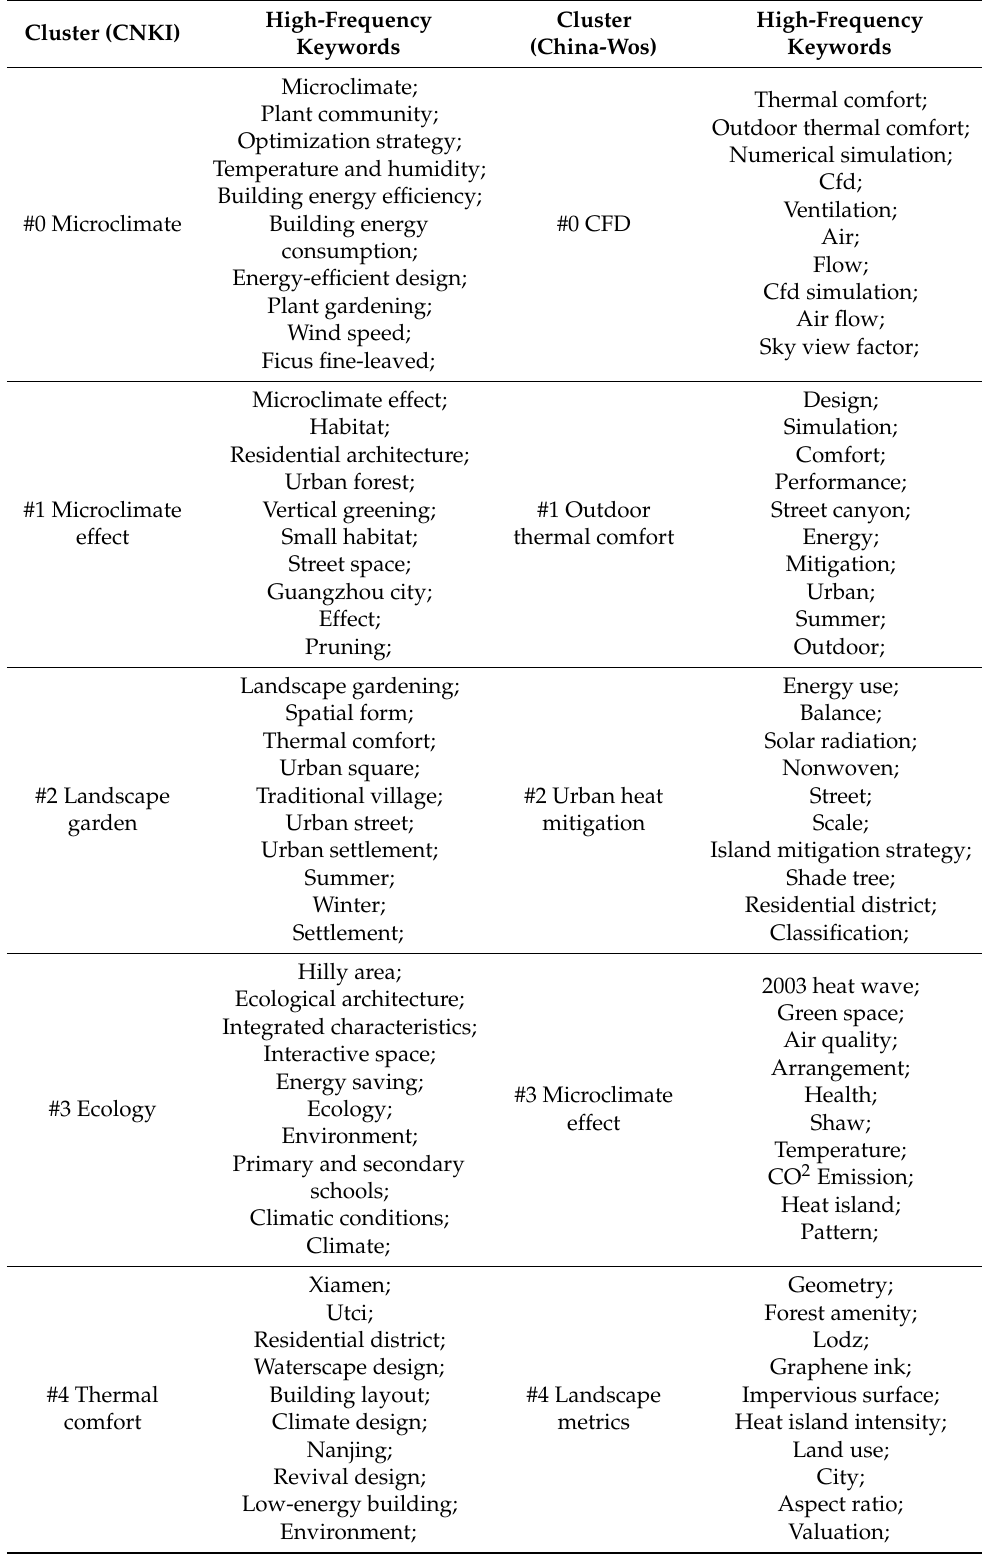
Table 1. Cluster of high-frequency keywords by Chinese